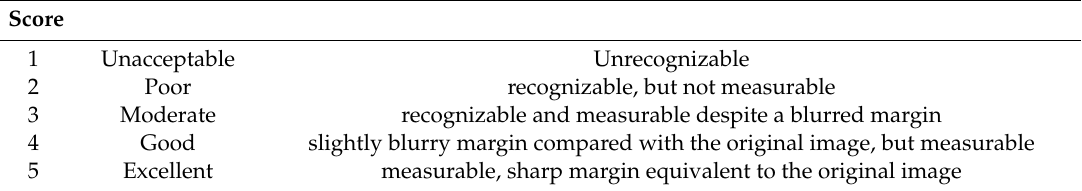
Table 2. Score criteria for the evaluation of normal local lesions (common iliac artery, internal iliac artery, and external iliac artery).